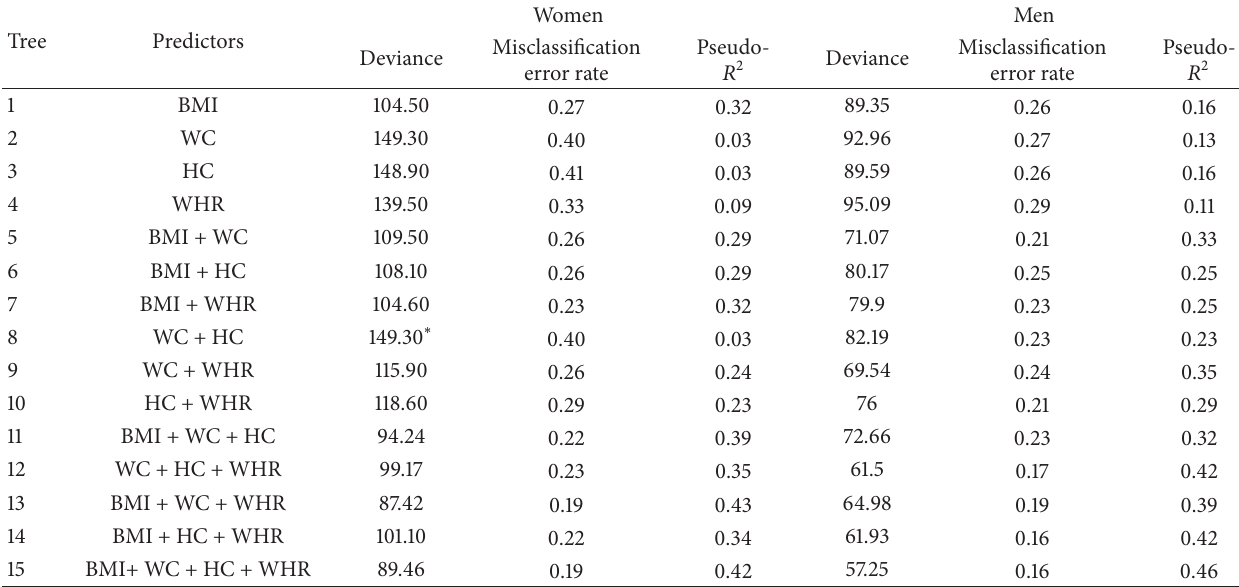
Table 2: Predictors, deviance, misclassification, and pseudo- 𝑅 2 by tree.